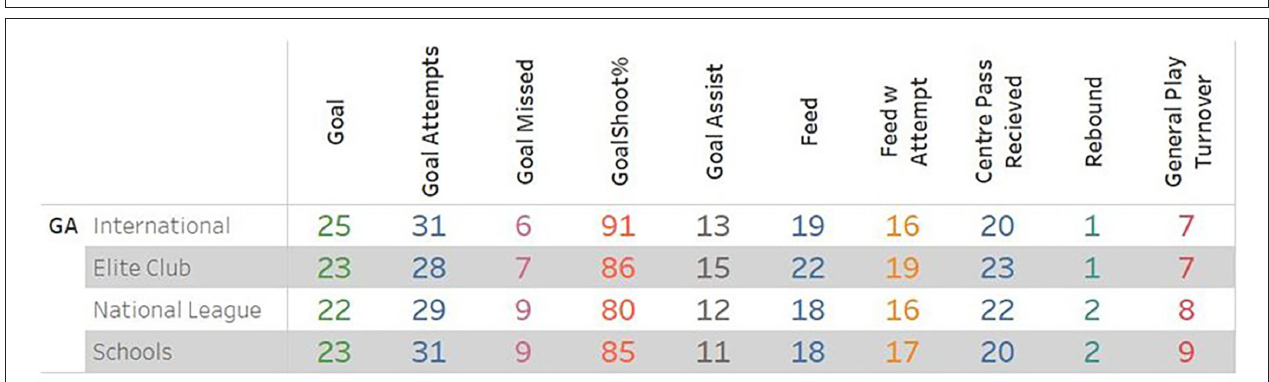
FIGURE 5 | Distribution plots of various level of netballs normative data for general play attack measures.